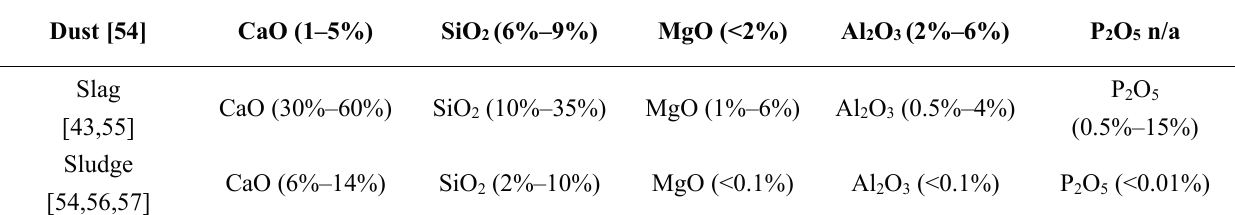
Table 2. Illustrative bulk composition of steel wastes with example of variations observed in the literature